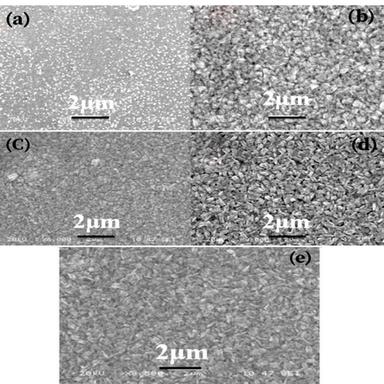
SEM micrographs of (a) pure (b) 1%, (c) 5%, (d) 10% and (e) 15% N doped NiO Films.